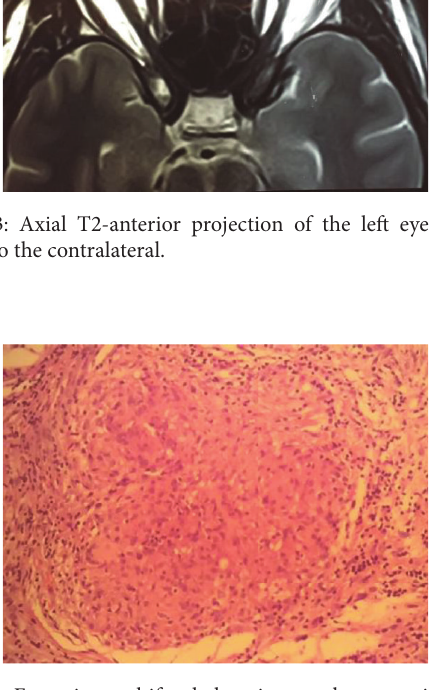
Figure 4: Extensive multifocal chronic granulomatous inflamma- tion, with numerous epithelioid macrophages and multinucleated giant cells, without evidence of necrosis (HE